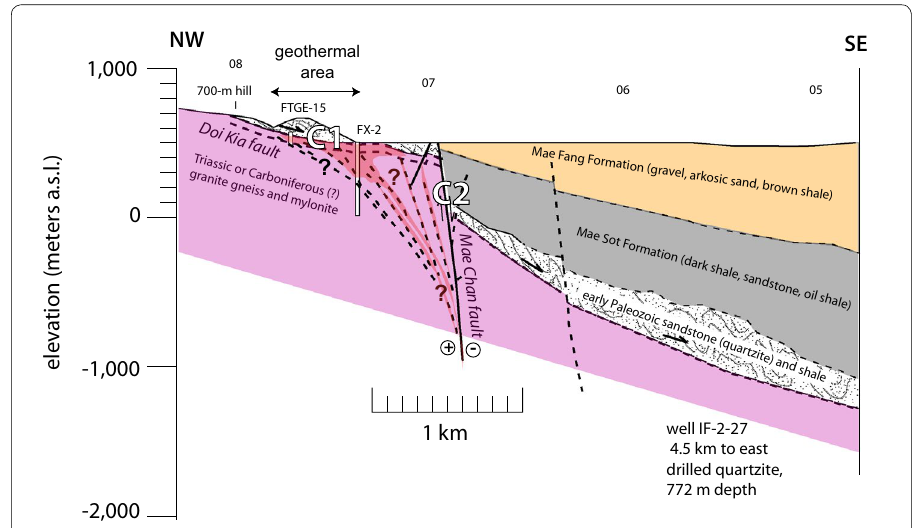
Fig. 10 NW–SE Cross section of the Fang geothermal area—location of section shown in Fig. 9. FTGE-15 and FX-2 are producing geothermal wells. C1 and C2 are MT anomalies discussed in